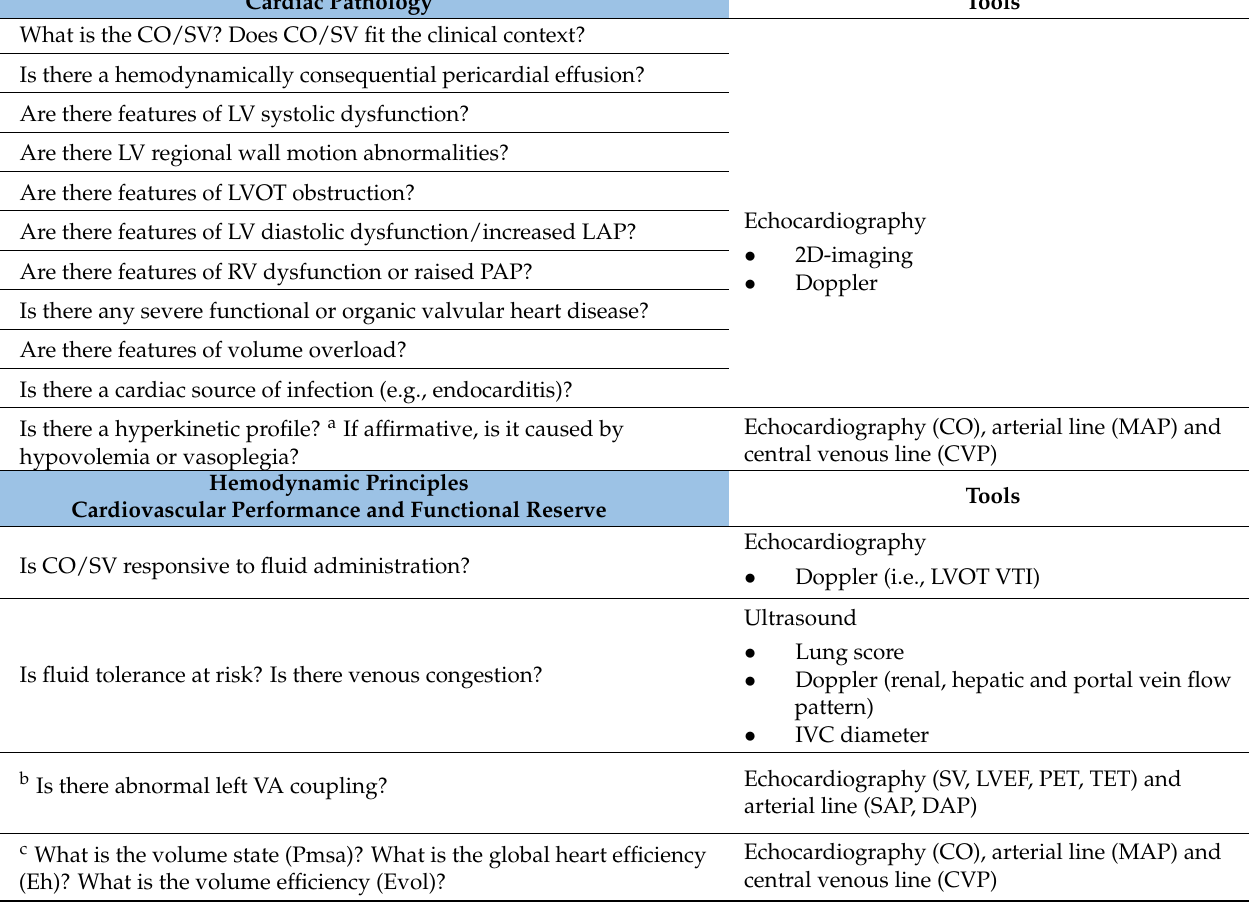
Table A1. Questions to be answered by a minimal toolkit consisting of ultrasound, arterial and central venous lines. Adapted with permission